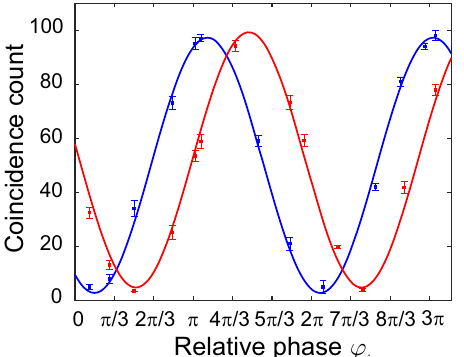
Fig. 6 Two-photon interference fringes for time-energy entangle- ment after QET. The coincidence counts are recorded by varying the relative phase φ i of MZI of idler photons while the phase of the signal one is set at φ s = π (blue line) and φ s = 3 π /2 (red line). Each coincidence count is measured for 10 s. The error bars represent one standard